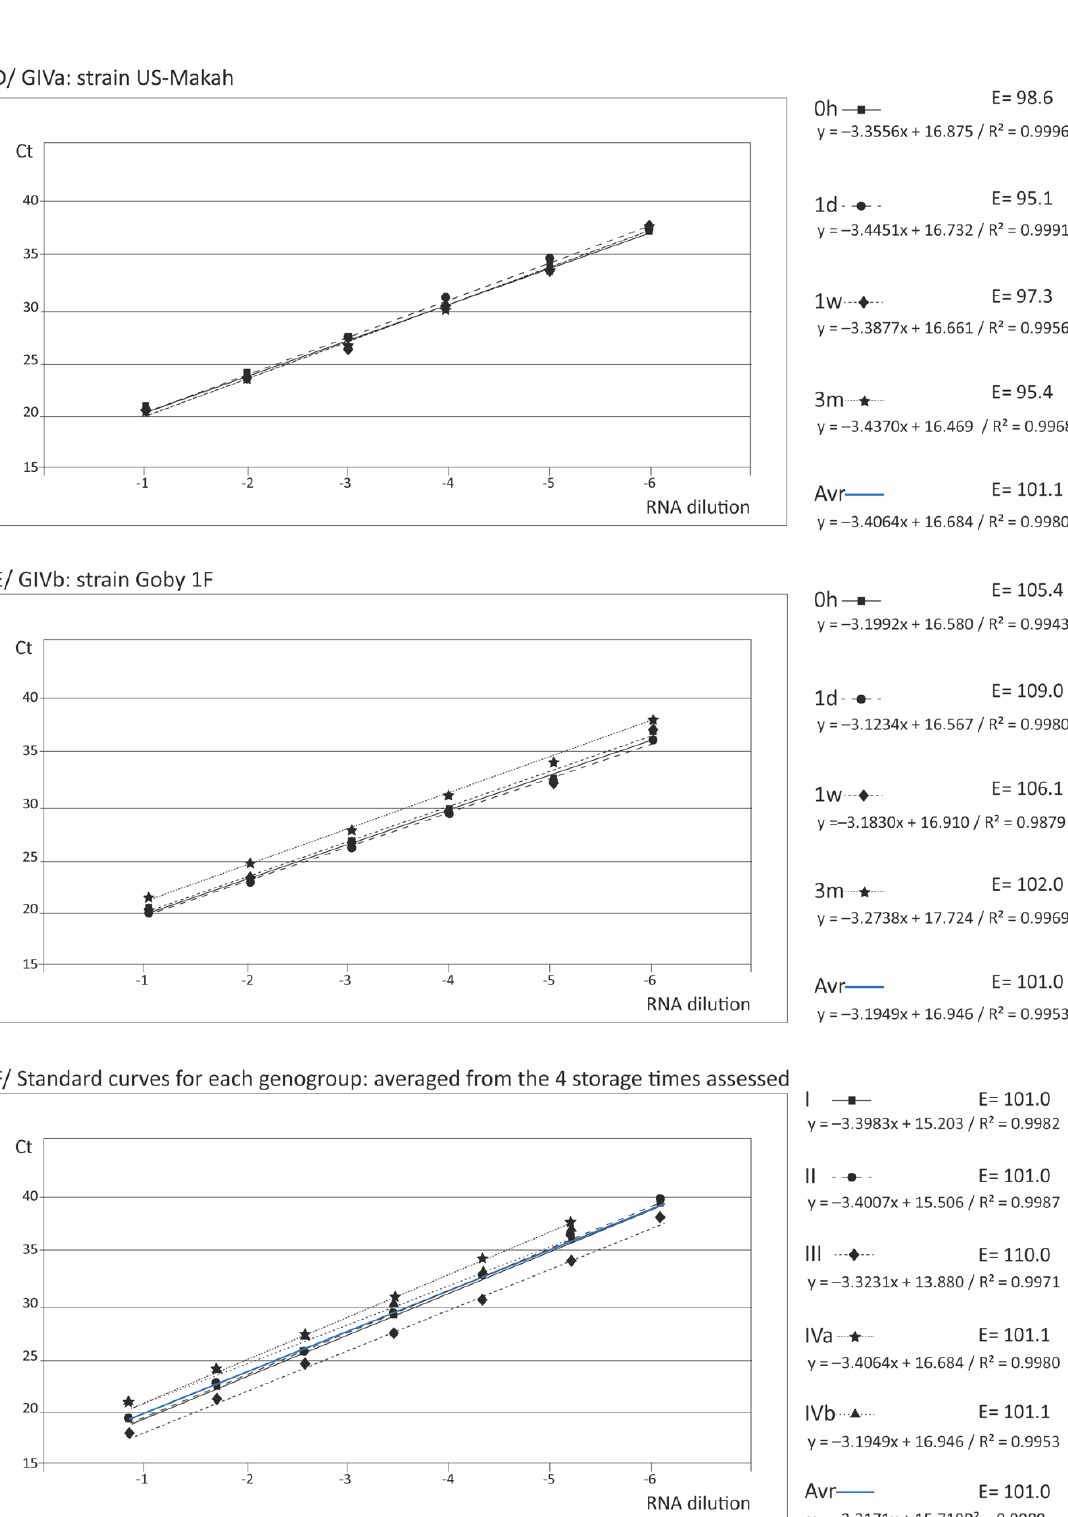
Figure 2. Standard curves with qPCR. For each genogroup, the standard curves obtained with the macroarray applying qPCR immediately after its preparation (0 h) and after the three storage times assessed (one day, one week, and three months) are shown. The equation of each curve ( 1 ), its reliability in terms of coefficient of determination (R 2 ) ( 2 ), and the efficiency of the amplification (E) ( 3 ), calculated from the formula E = 10 − 1/S − 1 (where S is the slope of the regression line) are indicated. For each genogroup, the average line (averaged from the 4 storage times) is also shown ( 4 ).